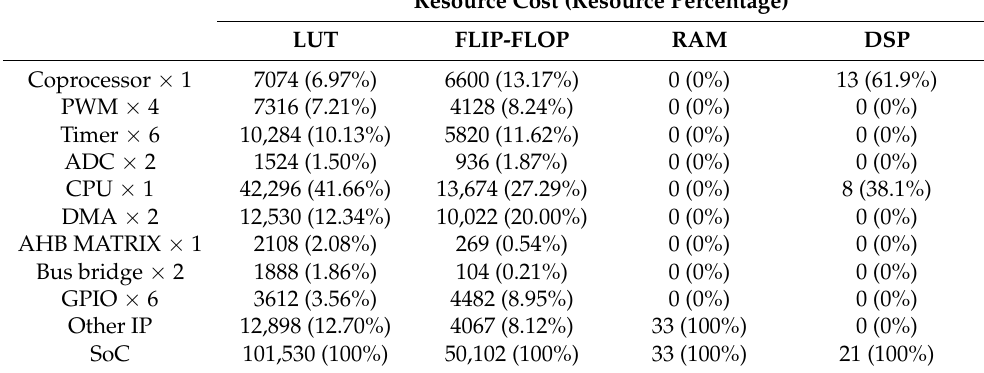
Table 2. SoC resource consumption .